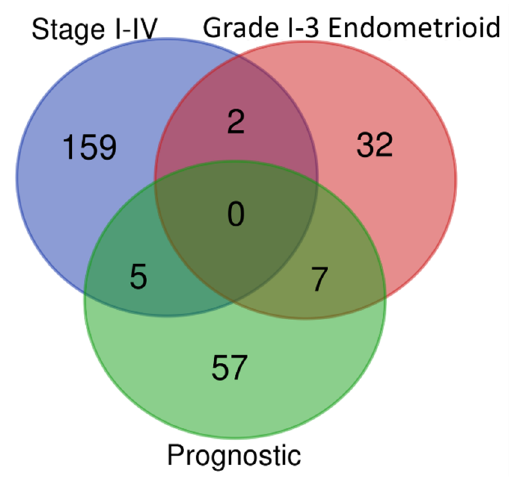
Figure 10. Venn diagram displaying the intersections of stage I-IV DEGs, Grades 1–3 DEGs and prognostic DEGs.